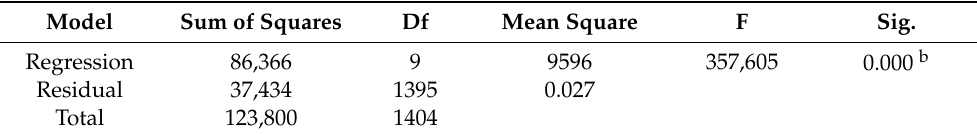
Table 6. ANOVA best teams. Table 8. ANOVA bottom